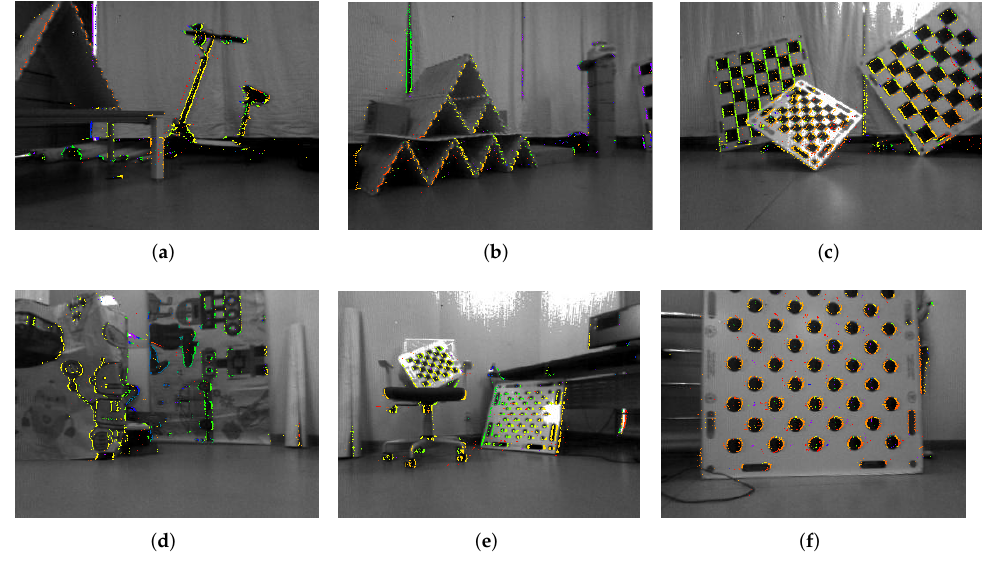
Figure 9. ( a – f ) are back-projections of the marked structure parts shown in Figure 8 overlaid onto the corresponding images captured under those poses. Warmer colors indicate closer points, while colder colors indicate larger